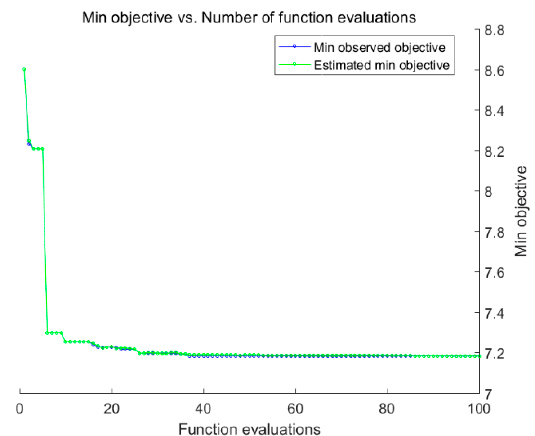
Figure A2. Bayesian hyper-parameter optimization process of SVR ensemble modelling.